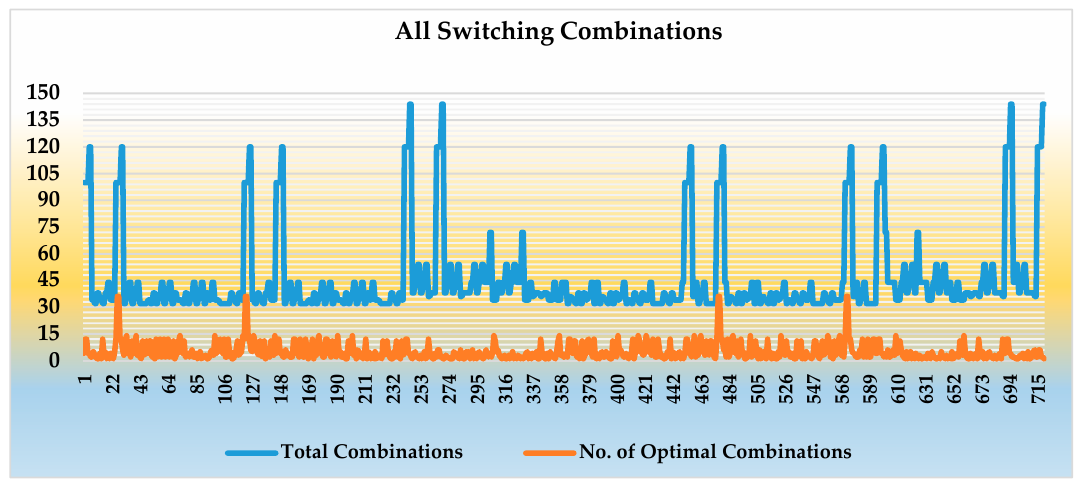
Figure 7 . Number of total and optimal switching combinations in un-optimized HCROS . Figure 7. Number of total and optimal switching combinations in un-optimized HCROS. Electronics 2019 , 8 , x FOR PEER REVIEW